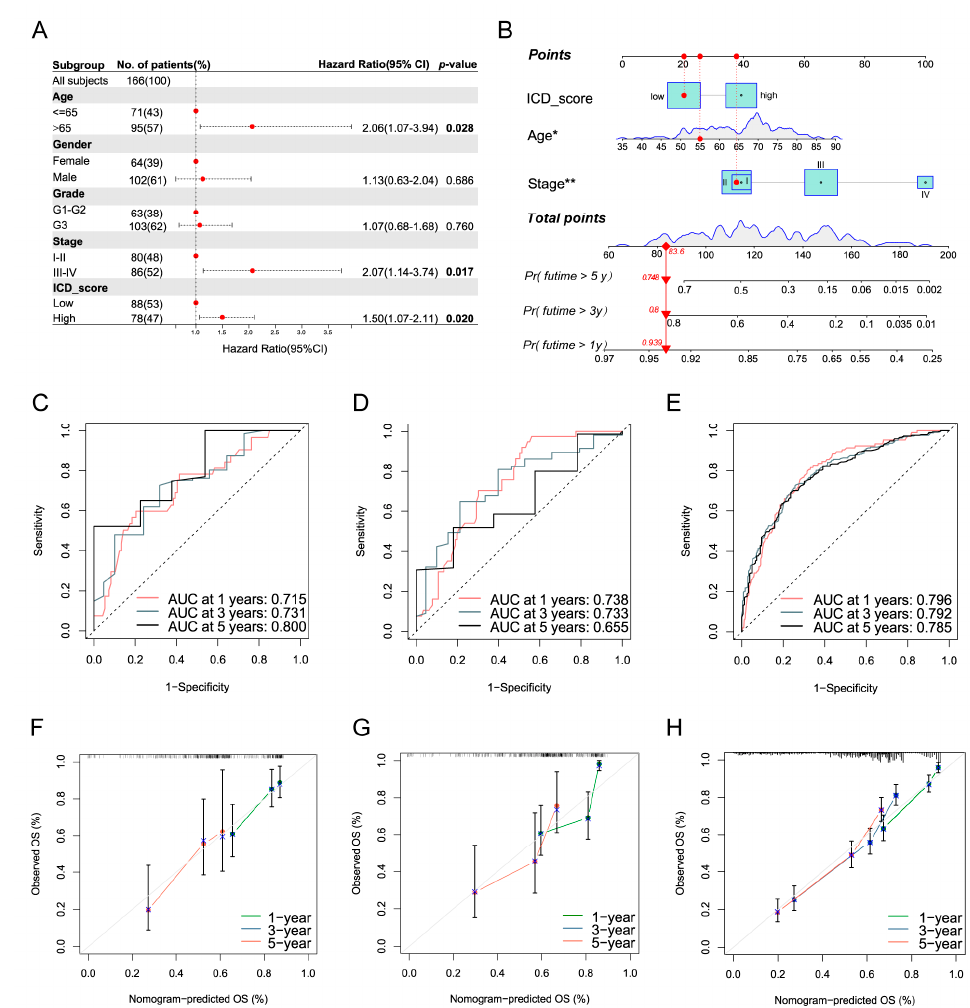
Figure 9. Construction of a nomogram predicting OS based on the ICD_score system in GC. ( A ) Multivariate analysis in the TCGA cohort. ( B ) Nomogram integrated the ICD_score system, age, and TNM stage for predicting the 1 ‐ , 3 ‐ , and 5 ‐ year OS of GC patients in the training set. ( C – E ) ROC curves for predicting the 1 ‐ , 3 ‐ , and 5 ‐ year OS in the training, testing, and external validation sets. ( F – H ) Calibration curves of the nomogram for predicting of 1 ‐ , 3 ‐ , and 5 ‐ year OS in the training, testing, and external validation sets. p values were shown as: * p < 0.05; ** p < 0.01.